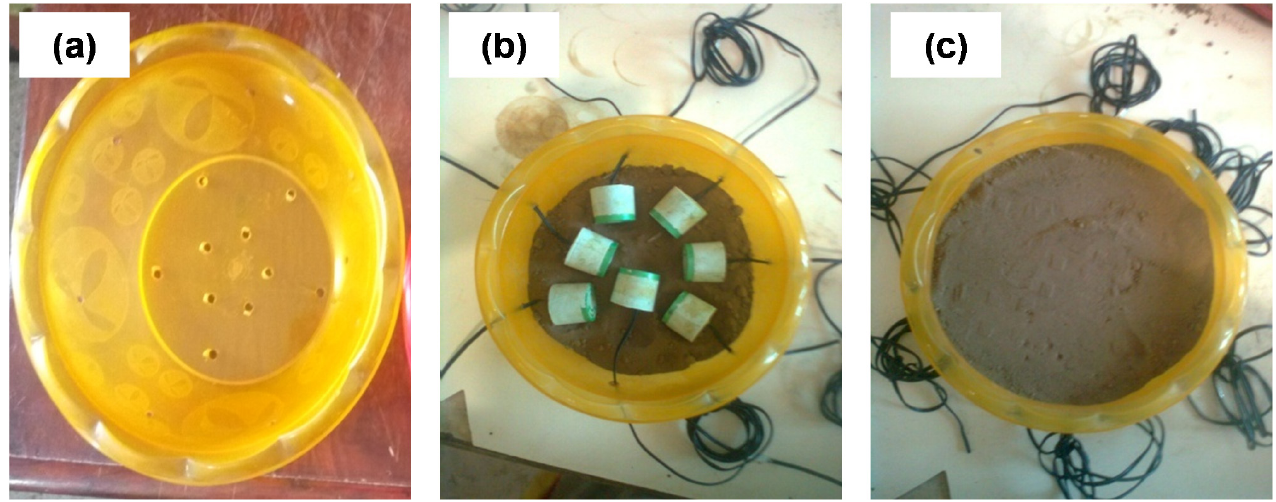
Figure 3. Pictorial representation of ( a ) bowl with holes to insert gypsum blocks, ( b ) placement of gypsum blocks for calibration, and ( c ) buried blocks in soil.